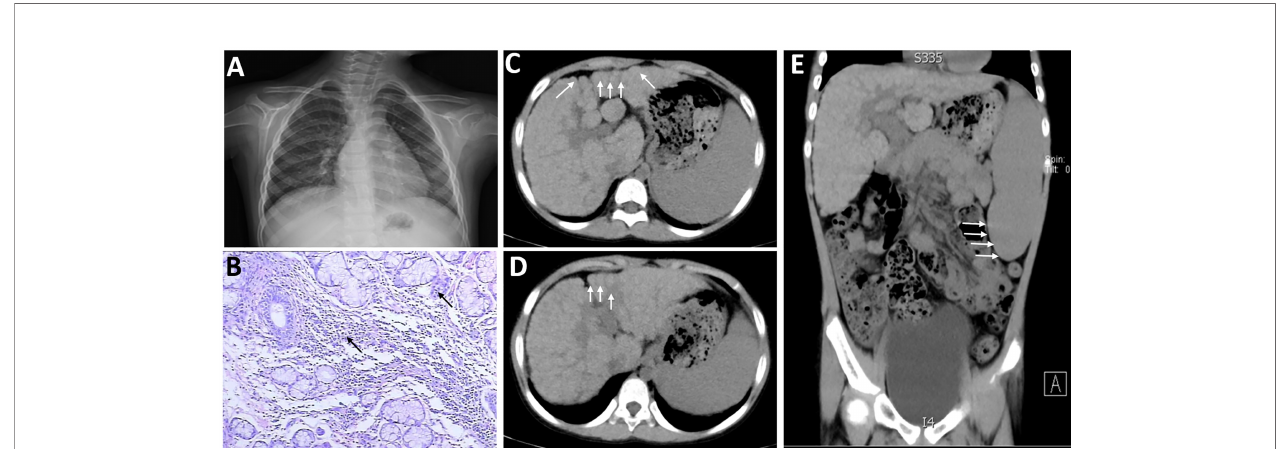
FIGURE 1 | Imaging features of the patient with both systemic lupus erythematosus (SLE) and Sjogren ’ s syndrome (SS) when she was 5 years old. The textures of both lungs were increased and blurred, and there were small patchy shadows (A) . There were 2 small foci of lymphocyte invasion in salivary gland tissue microscopically (>50/focus) after labial gland biopsy (B) . (C – E) The volume of the liver was reduced, and each lobe was out of proportion, especially the right lobe. The left and caudal lobes of the liver were enlarged and the fi ssure was widened. The surface of the liver was not smooth, small nodular protrusions could be seen (shown by arrows), and the density of liver parenchyma was not uniform. The spleen was markedly enlarged and about 6 cm in thickness (shown by